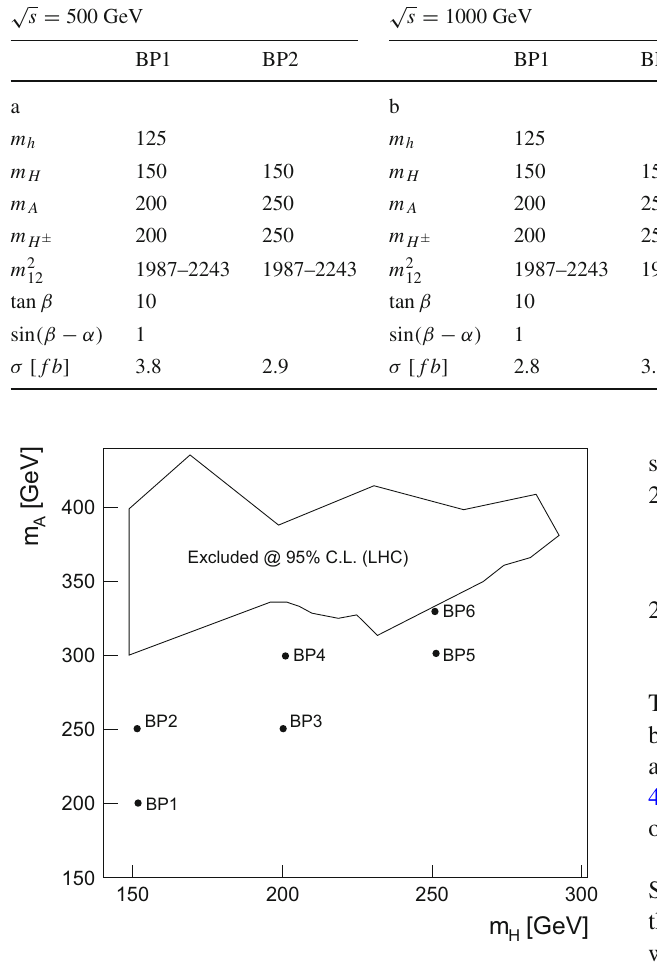
Fig. 1 The selected benchmark points and the current LHC excluded area [39]